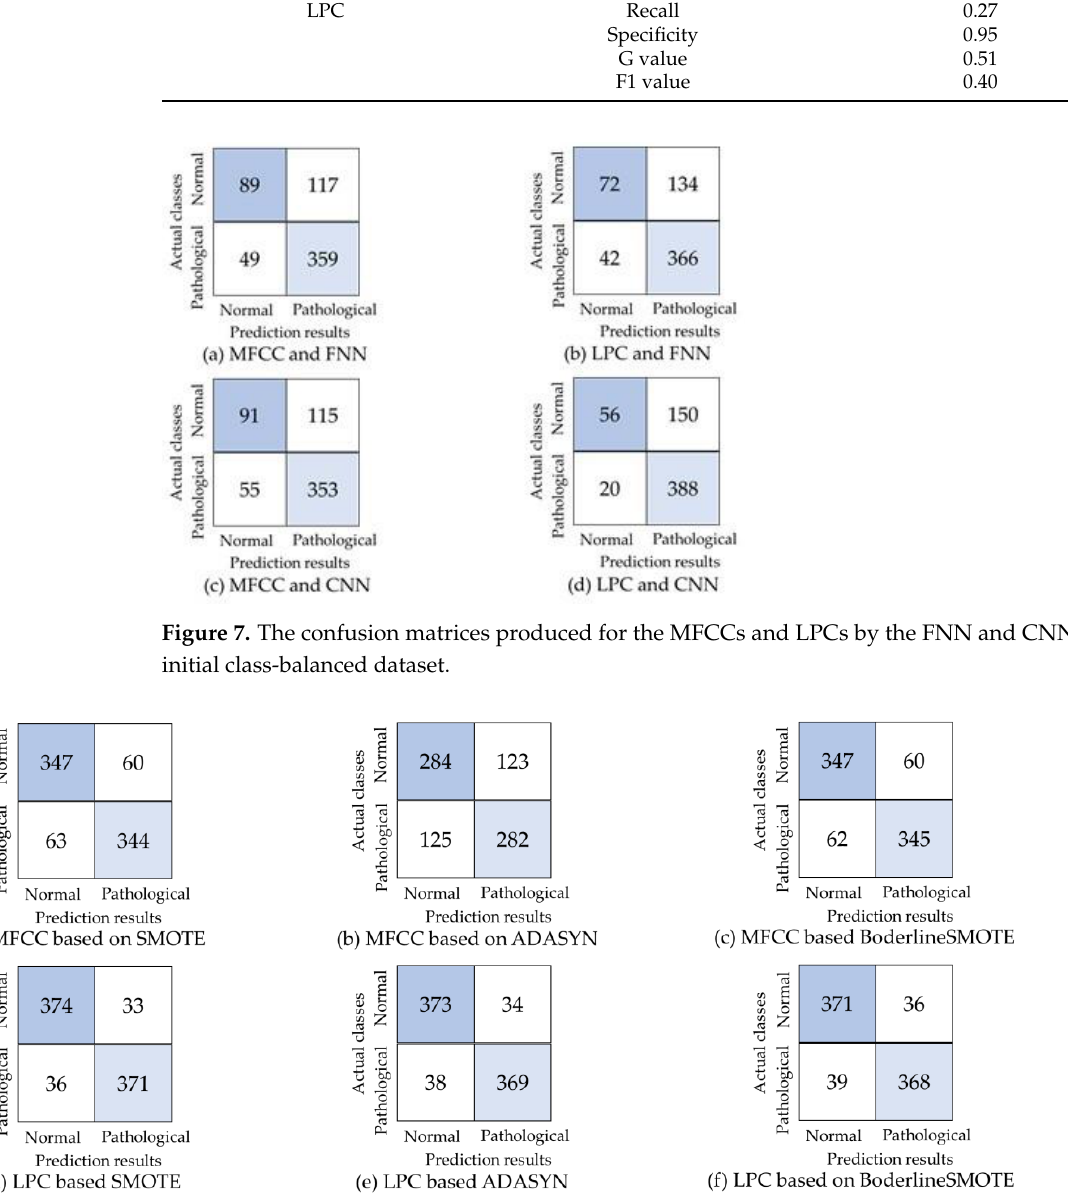
Table 5. Evaluation measures produced by each model on the class-balanced SVD.